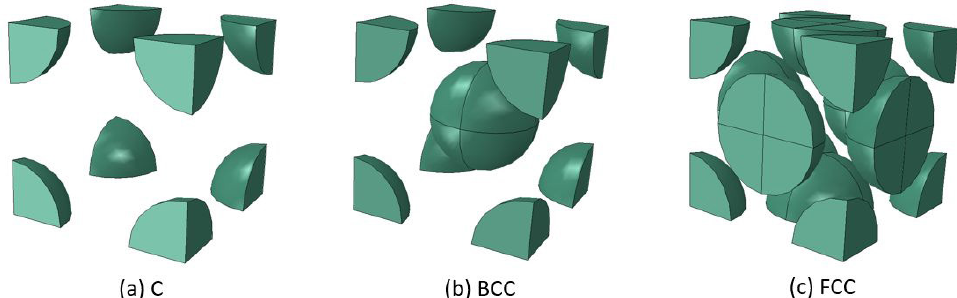
Figure 5. Layout of regular inclusion arrangements in the